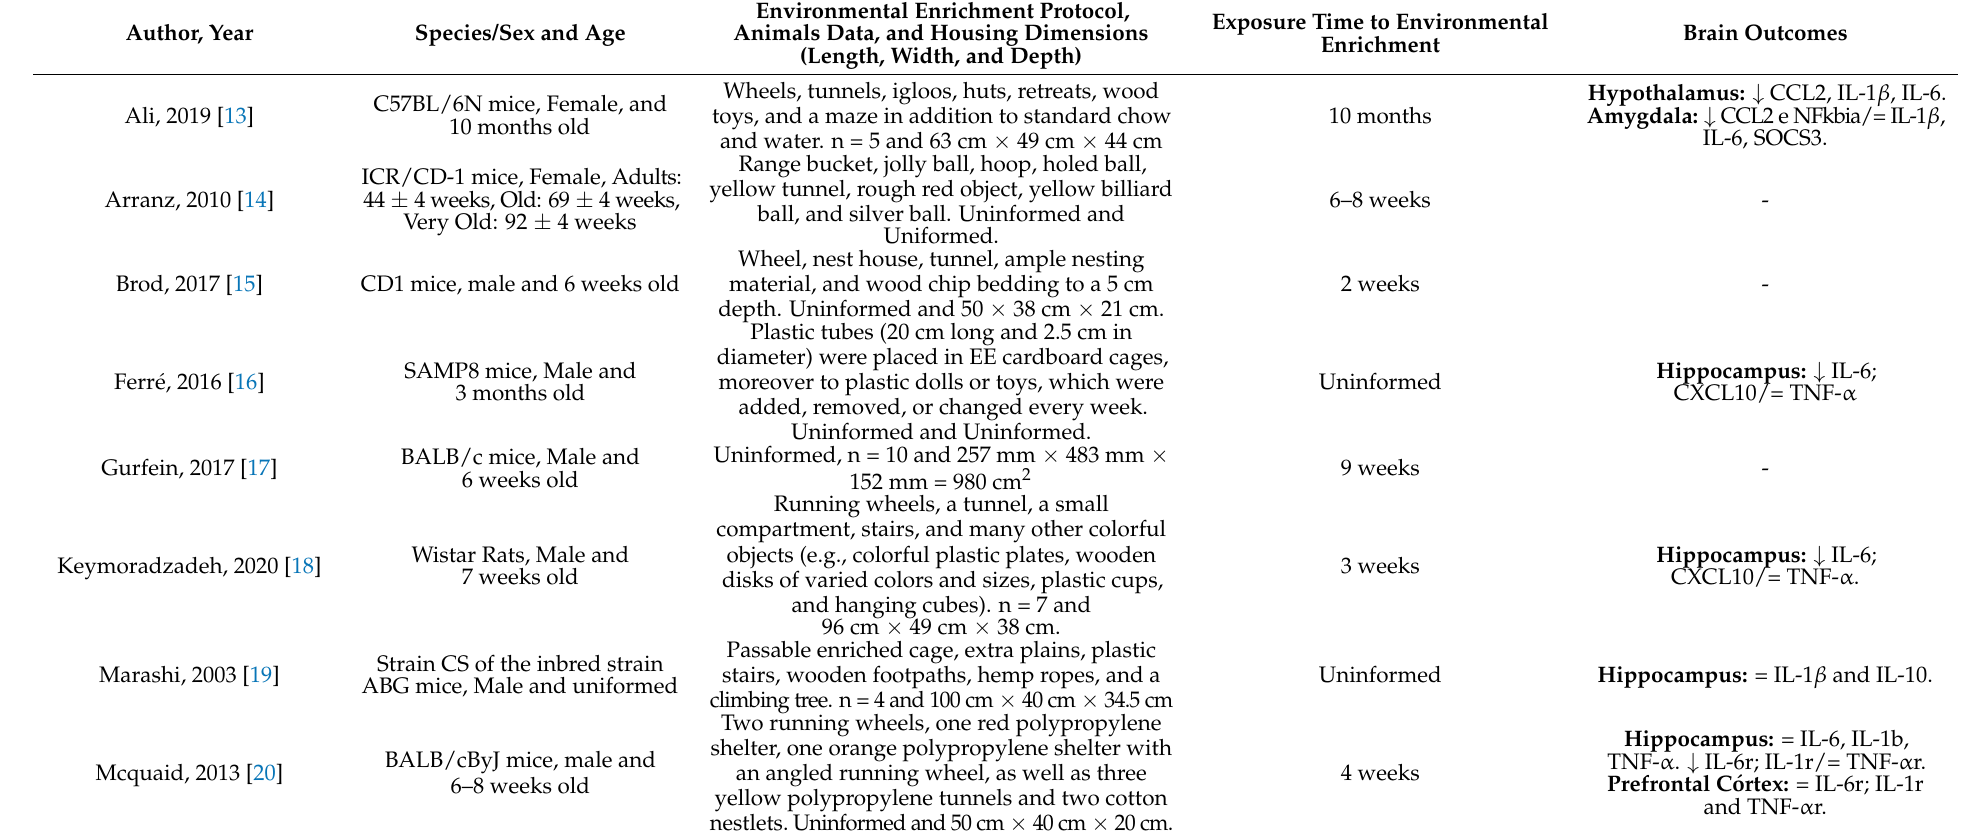
Table 4. Sample description and characterization of environmental enrichment protocols and Brain